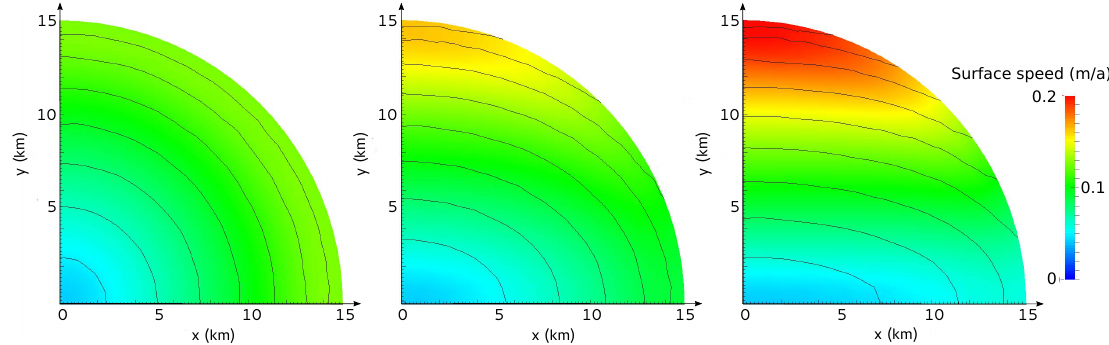
Figure 3. The three domes stabilized at steady state: surface contour lines (spacing: 1m) and surface speed (ma − 1 ) for α = 2 (left), α = 3 (middle) and α = 6